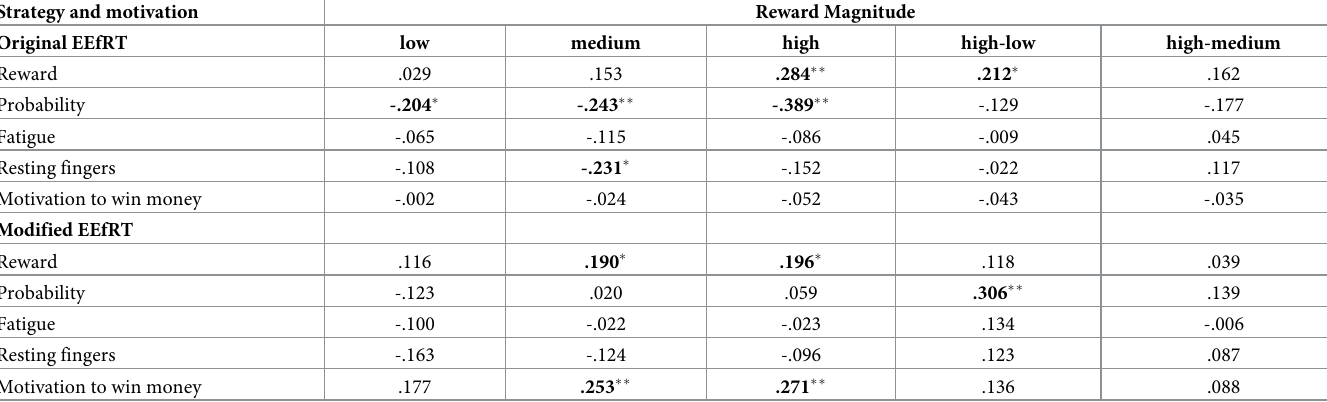
Table 8. Zero-order correlations between the original EEfRT (percentage of hard-task -choices), the modified EEfRT (mean number of clicks) and follow-up ques- tions concerning task strategy and motivation in Study 1 for different reward magnitudes. Strategy and